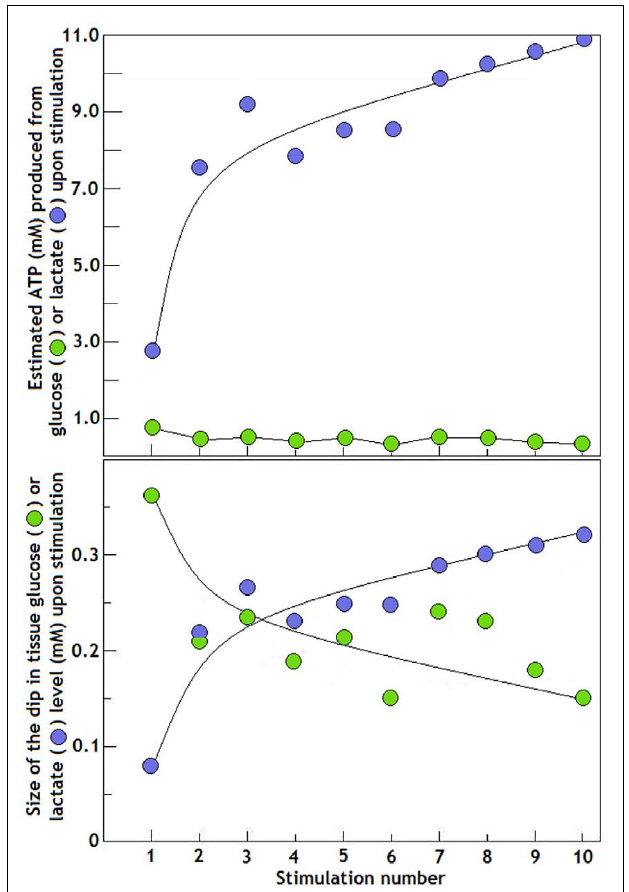
FIGURE 3 |The time course of changes in the amplitude of the dip in tissue glucose and lactate levels in the rat hippocampal dentate gyrus after each of the 10 electrical stimulations applied to the perforant pathway at intervals of 2min (bottom panel). The amplitude of each dip (in mM) was calculated from the data of Hu andWilson (1997b) as reproduced in Figure 2 .The upper panel illustrates the estimated ATP amount produced based on the size of the dip (in mM) in tissue glucose and lactate levels as shown in the bottom panel.The estimated ATP levels were calculated as follows: the glucose measured dip (in mM) was multiplied by 2, which is the net formation of 2mol of ATP for each mole of glycolytically metabolized glucose; the lactate measured dip (in mM) was multiplied by 34, which is the net formation of 34mol of ATP for every 2mol of lactate (formed glycolytically from 1mol of glucose) metabolized via the mitochondrialTCA and the oxidative phosphorylation